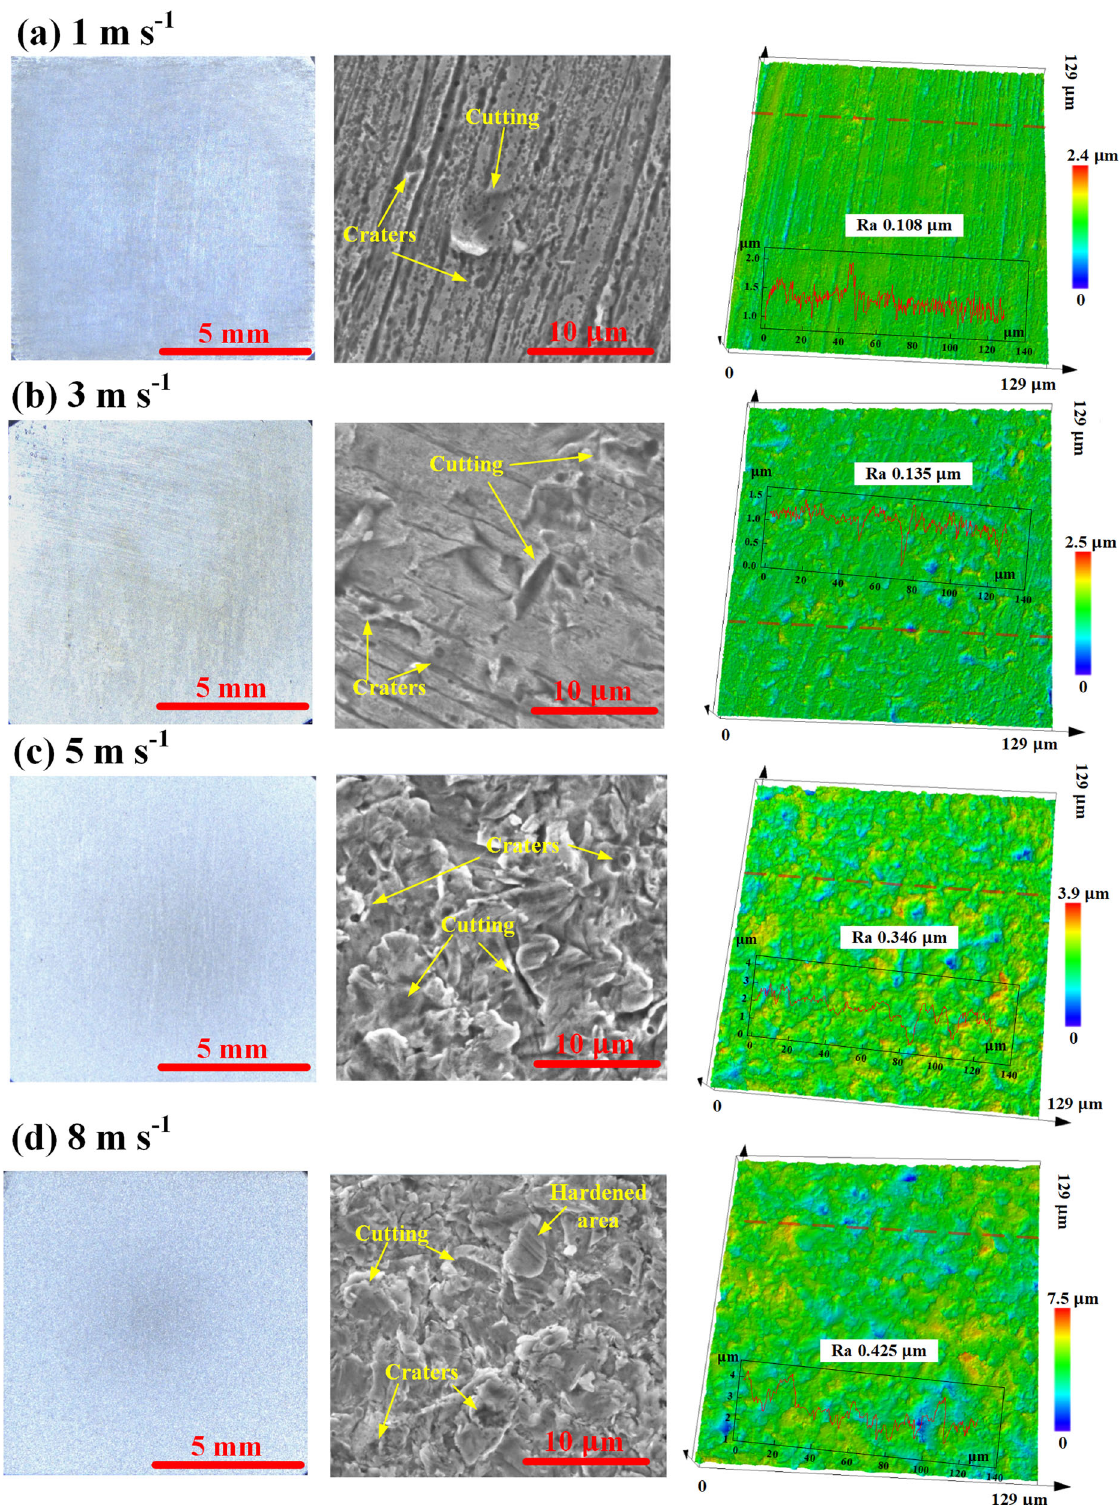
Fig. 6 Photos, local SEM images, and local 3D pro fi les of the steel samples after pure erosion experiments at different fl ow velocities. a 1 m s − 1 , b 3 m s − 1 , c 5 m s − 1 , and d 8 m s − 1 . well. It is seen from Fig. 8c that the areas of the ‘ fl ow marks ’ morphologies present as completely pitting damage when the fl ow velocity further increases to 5 m s − 1 (Fig. 8e) and 8 m s − 1 become small and some scattered pits appear on the steel surface (Fig. 8g). The corrosion products are observed inside the pits. The at 3 m s − 1 . In this case, most of the corrosion products are concentrated in the ‘ fl ow marks ’ and pits. The erosion − corrosion results of the Raman spectroscopy in the sand-entraining seawater npj Materials Degradation (2021) 56 Published in partnership with CSCP and